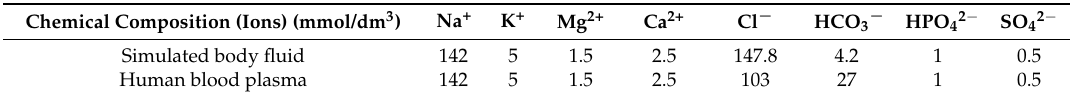
Table 1. Chemical composition of immersion